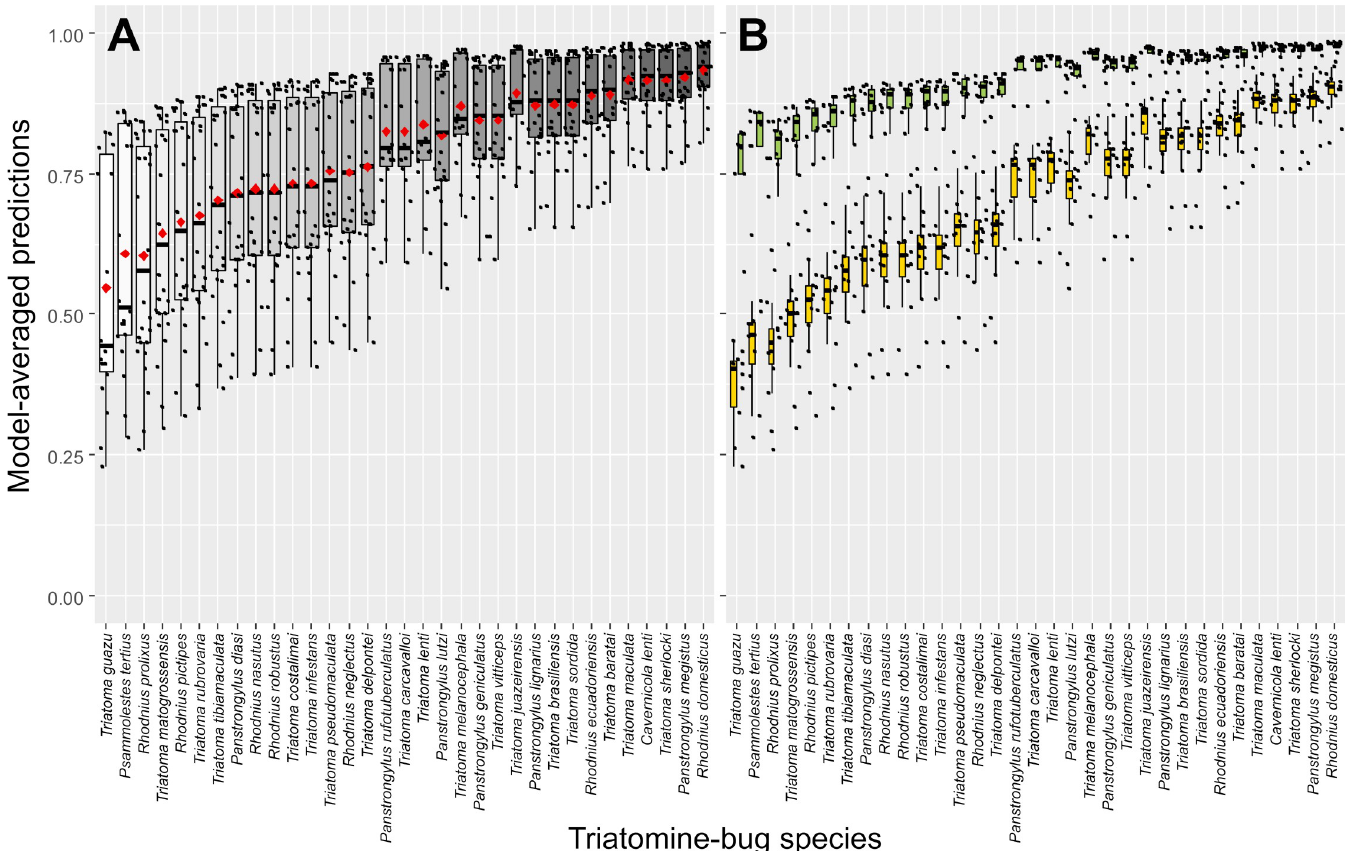
Fig 3. Predicted proportions of T RIATO D EX -based correct identification (by 27 users) across 33 triatomine-bug species. Predictions are derived using Akaike weights from a set of 512 generalized linear mixed models. A , overall plot; in B , values are plotted separately for users with (green boxplots) and without (orange boxplots) specialized training in triatomine-bug taxonomy; note that users with specialized training did consistently better than those without across species. Black dots are species- and user-specific predictions; boxplots show medians (thick horizontal lines), quartiles (boxes), and values that fall within 1.5 times the interquartile range (whiskers); red diamonds are